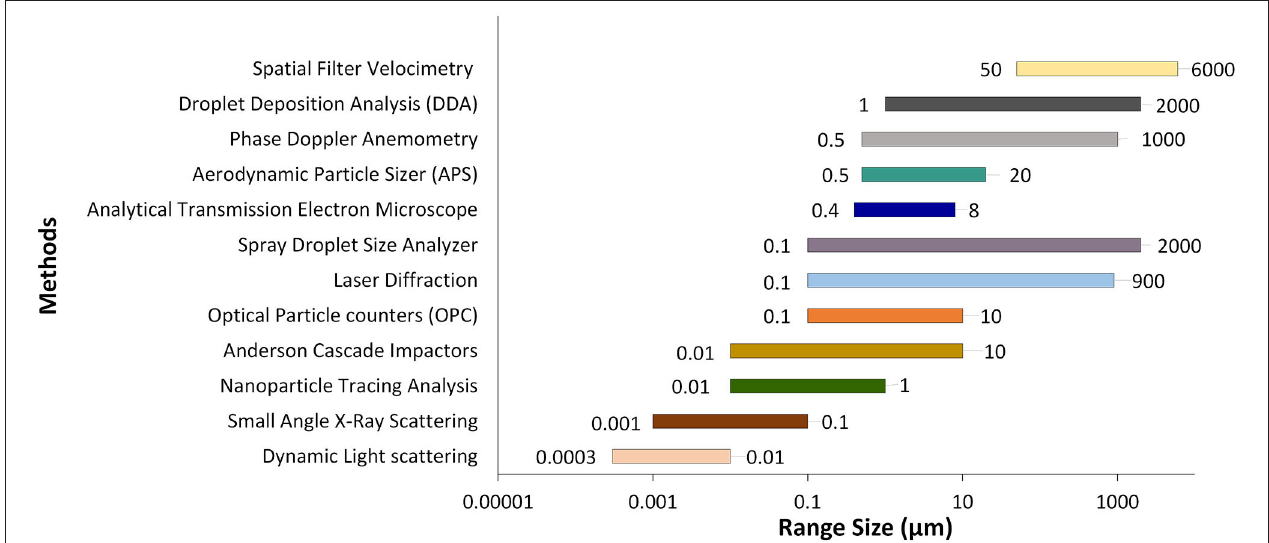
FIGURE 1 | A summary of identified bioaerosol particle size distributions measured using select